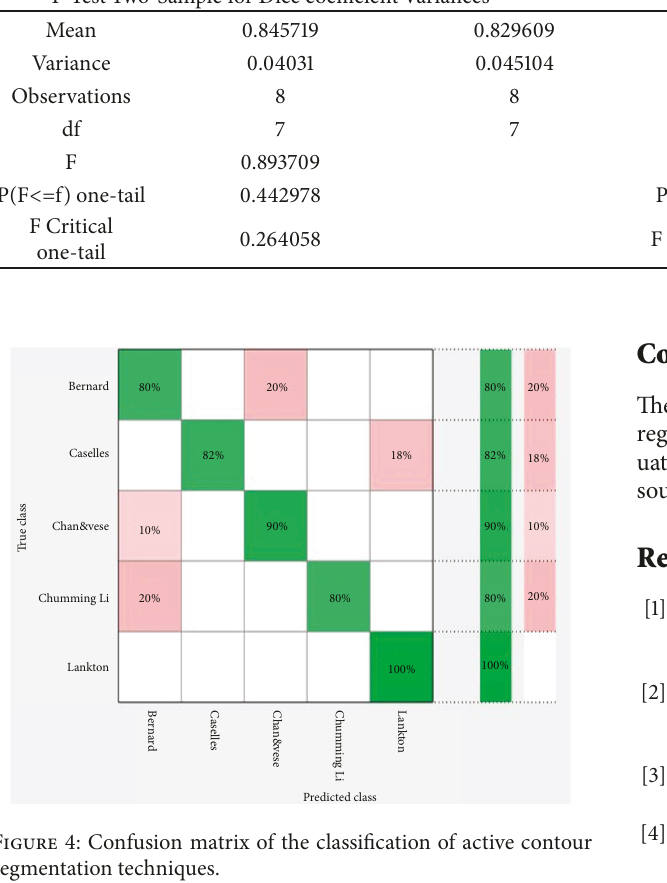
Table 3: F-Test for Variances of Caselles and Lankton Method. F-Test Two-Sample for Dice coefficient Variances